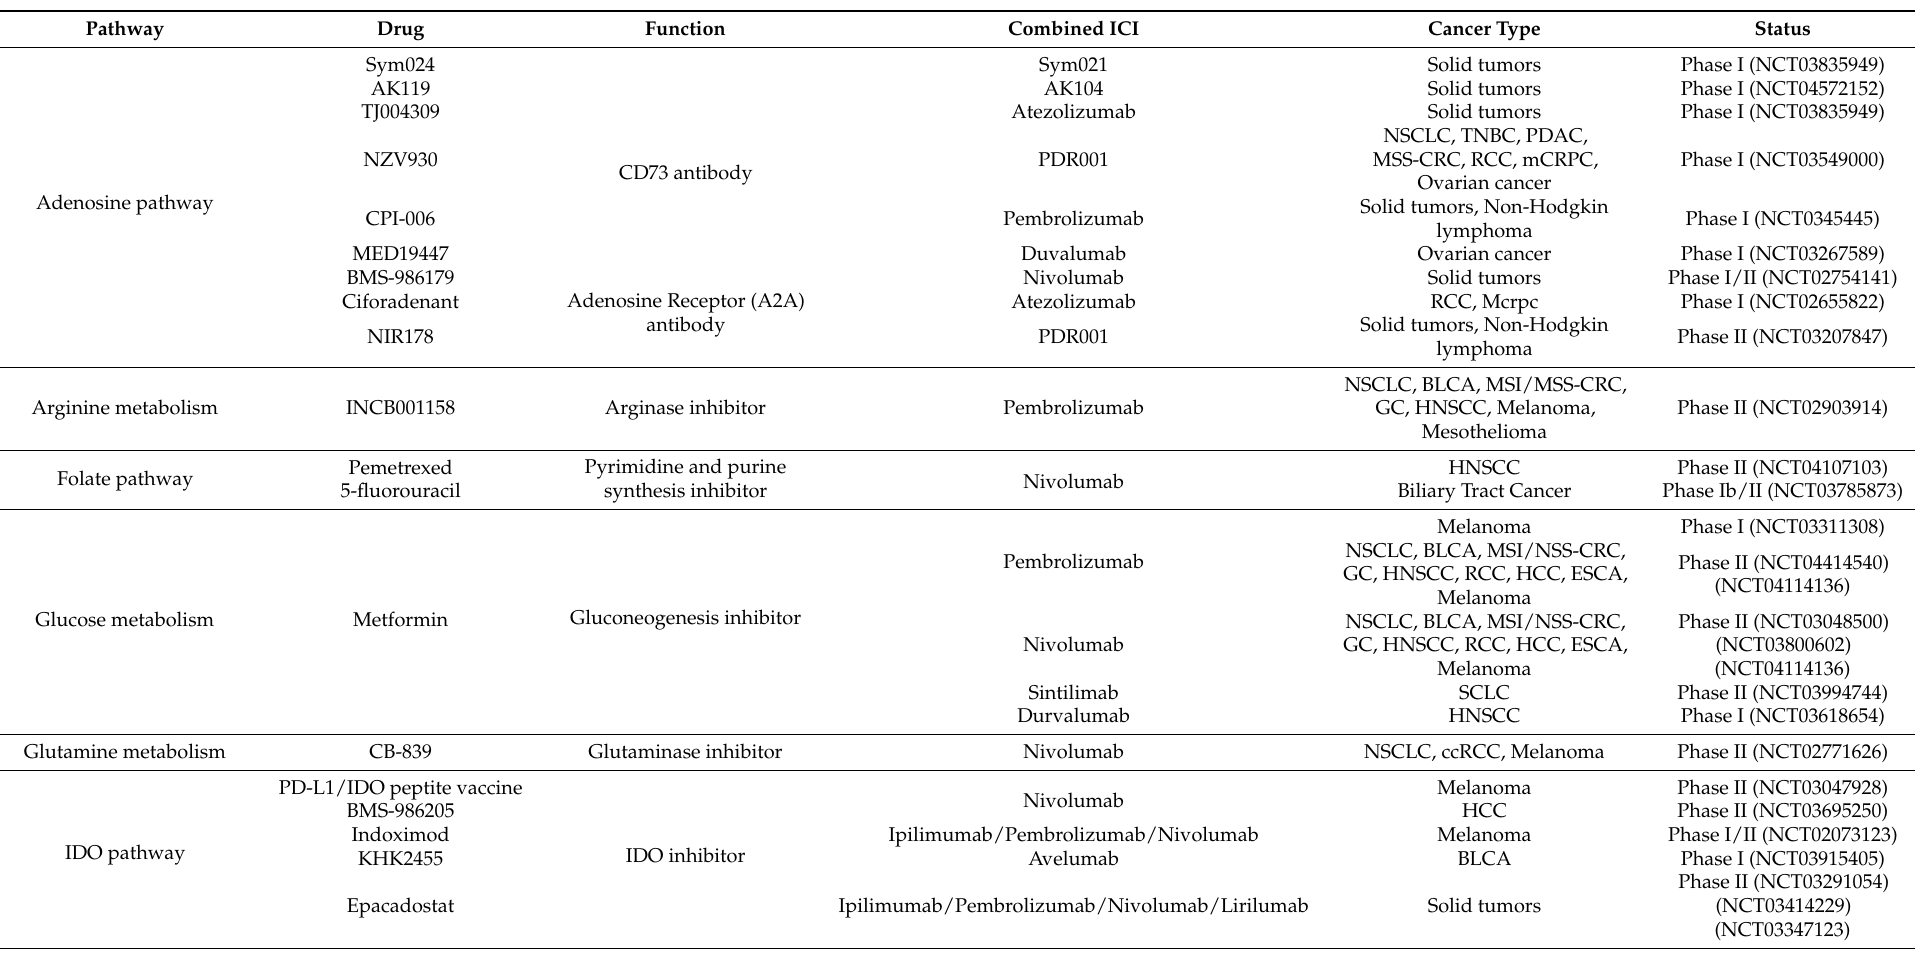
Table 1. Ongoing clinical trials targeting immunometabolism in combination with ICIs. Bladder Urothelial Cancer (BLCA), Clear Cell Renal Cell Carcinoma (ccRCC), Colorectal Cancer (CRC), Esophagus Carcinoma (ESCA), Gastric Carcinoma (GC), Hepatocellular Carcinoma (HCC), Head and Neck Squamous Cell Carcinoma (HNSCC), Metastatic Castration Resistant Prostate Cancer (mCRPC), Microsatellite Instability/Microsatellite Stable-Colorectal Cancer (MSI/MSS-CRC), Renal Cell Carcinoma (RCC), Pancreatic Ductal Adenocarcinoma (PDAC), Triple Negative Breast Cancer